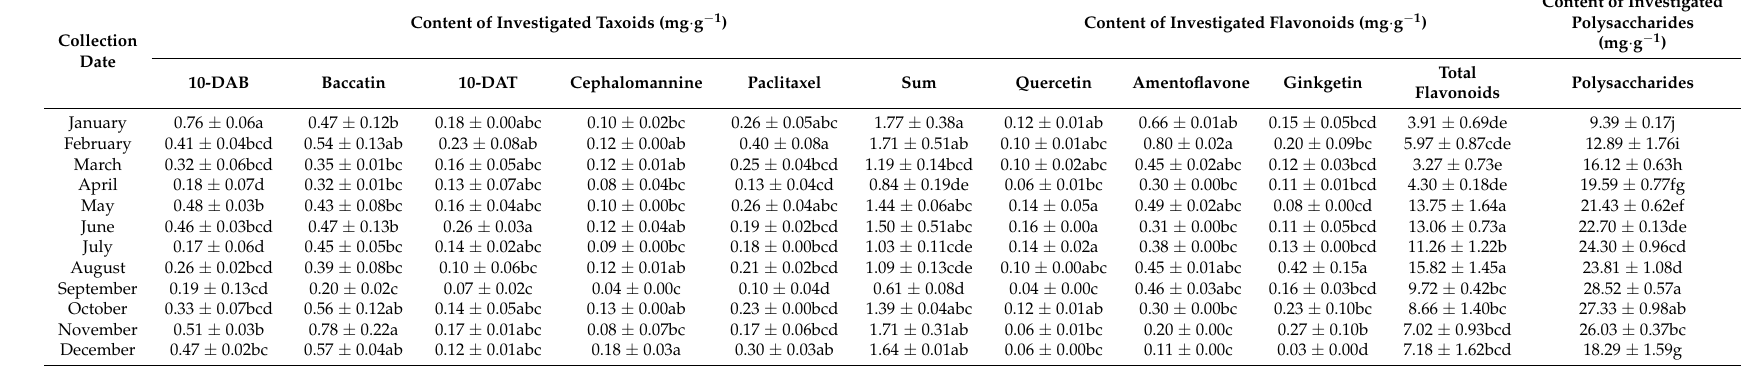
Table 1. Variation of taxoids, flavones and polysaccharides contents in T. wallichiana var. mairei .